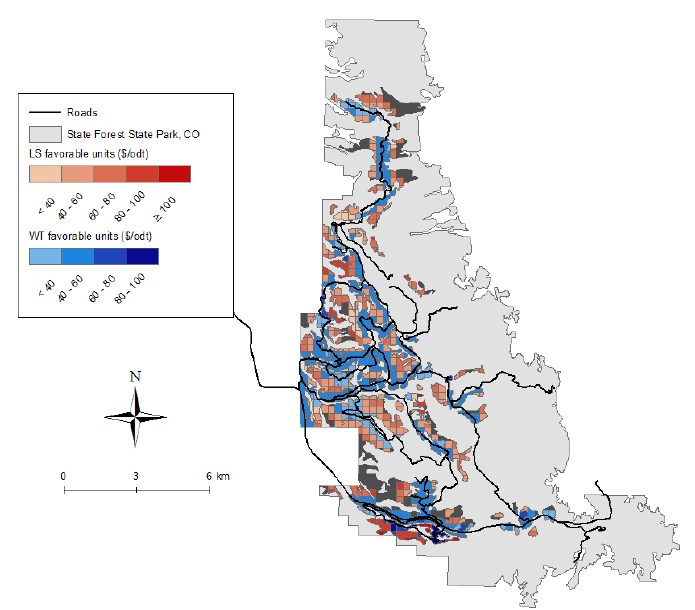
Figure 4. Economically favorable harvesting methods shown across the lodgepole pine stands in the Colorado State Forest State